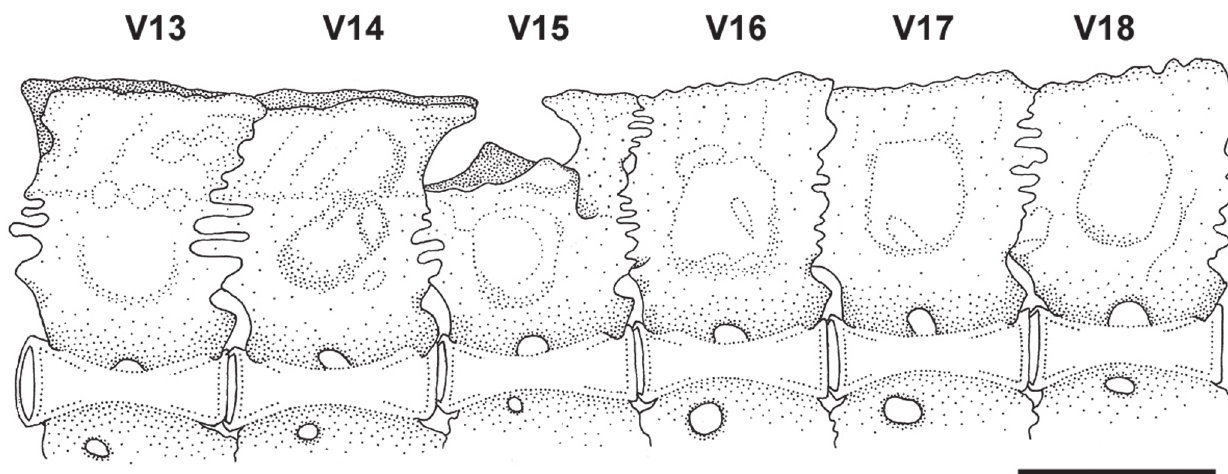
Fig. 1. Vertebral column of Otothyropsis marapoama , MCP 42119, 30.8 mm SL, showing the degree of sutural articulation between contiguous neural spines. Scale bar = 1 mm.